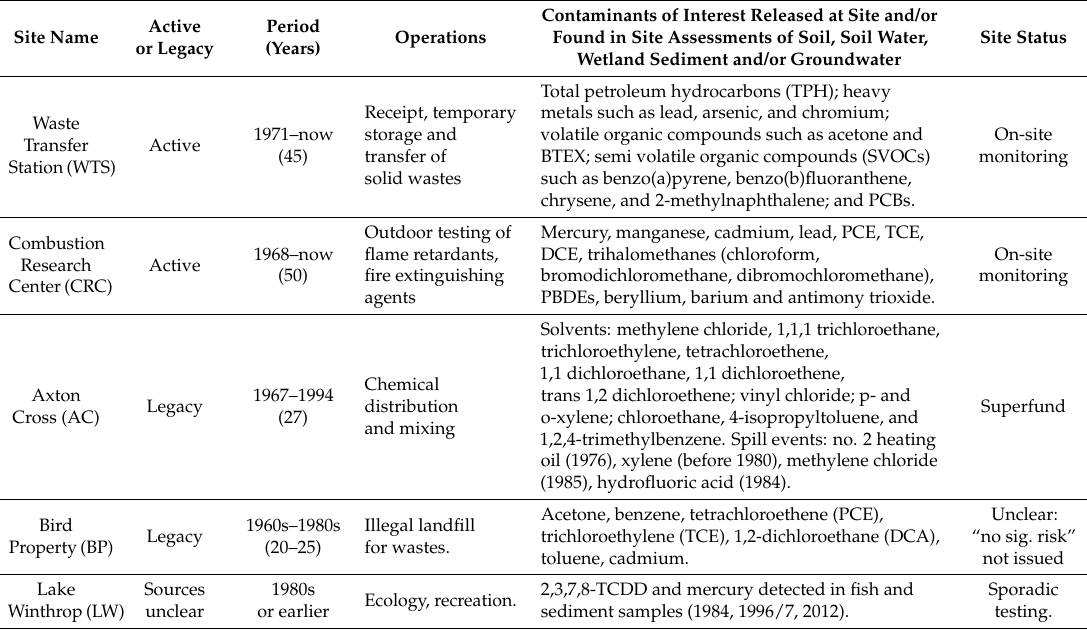
Table 2. Sites of concern, their contaminants of interest, and